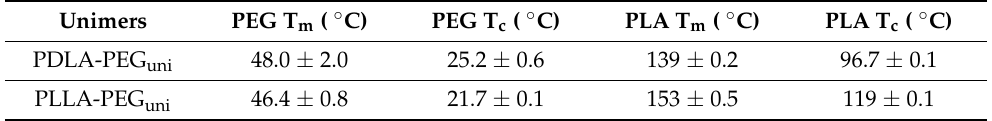
Table 2. Melting temperature (Tm) and crystalline temperature (Tc) of synthesized PLA-PEG charac- terized by differential scanning